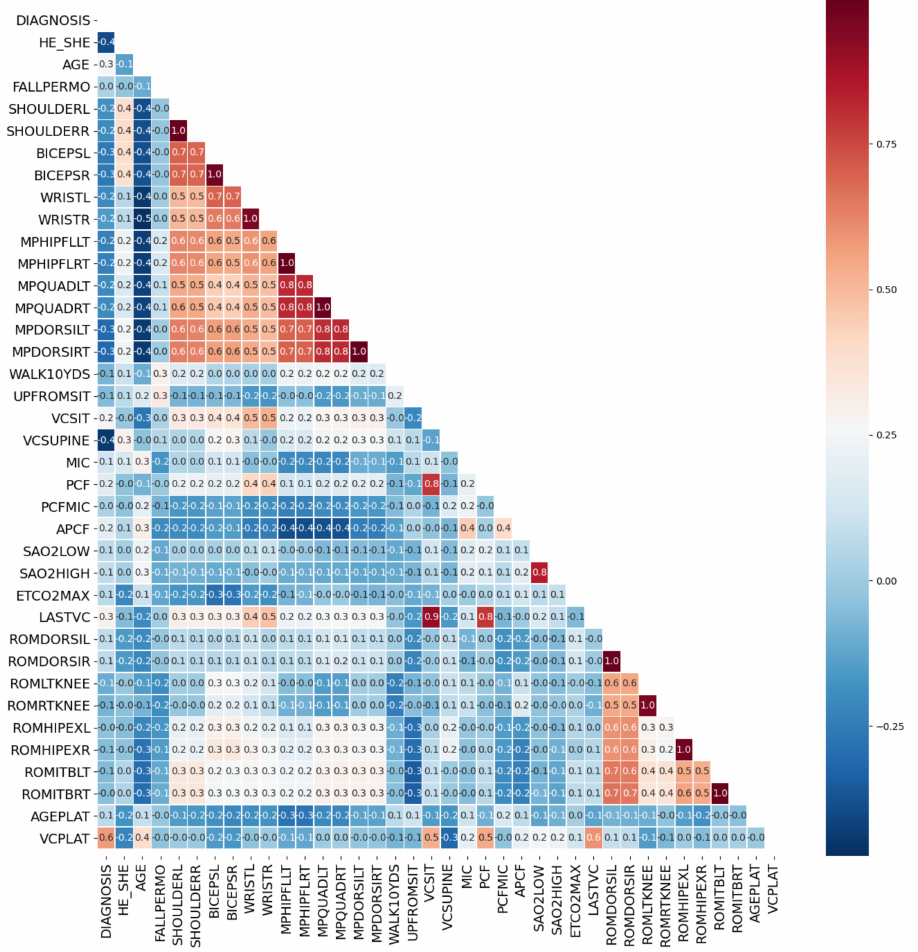
Figure 9. Correlation coefficient matrix heat map. The horizontal and vertical axes represent medical features, and the numbers in the small squares represent the Spearman correlation coefficients between the two features. Color represents the degree of correlation. The larger the correlation coefficient, the darker the color, which means that the two features are more